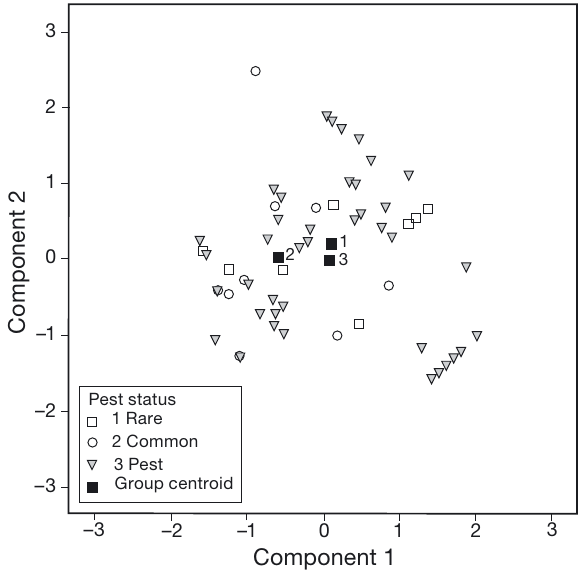
Fig. 1. Canonical discriminant functions plot showing the dis- tribution of instances of shell-boring polydorids with different pest status as they are separated according to component 1 (larval mode and worm species) and component 2 (host species and culture system). See ‘Materials and methods’ for details on